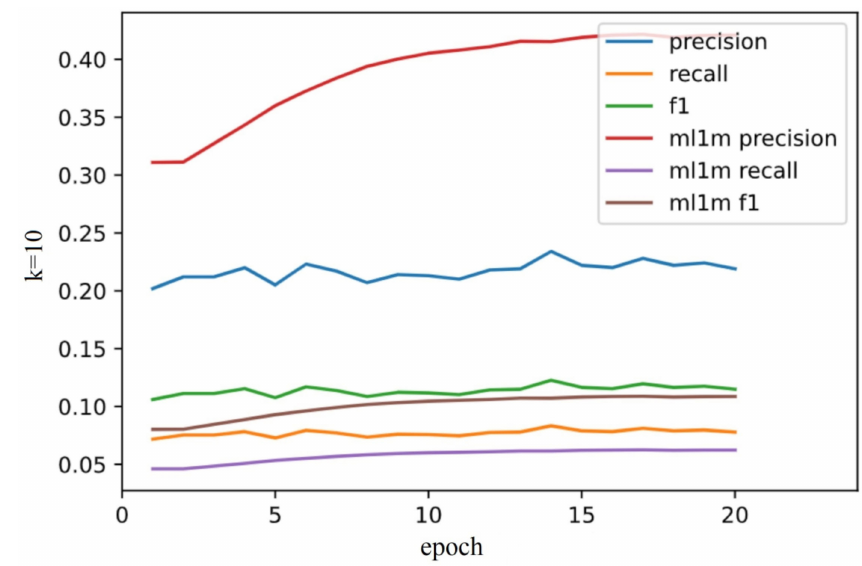
Figure 6. A reflection of the changes in precision, recall, and f1 of the Top 10 on the test set.